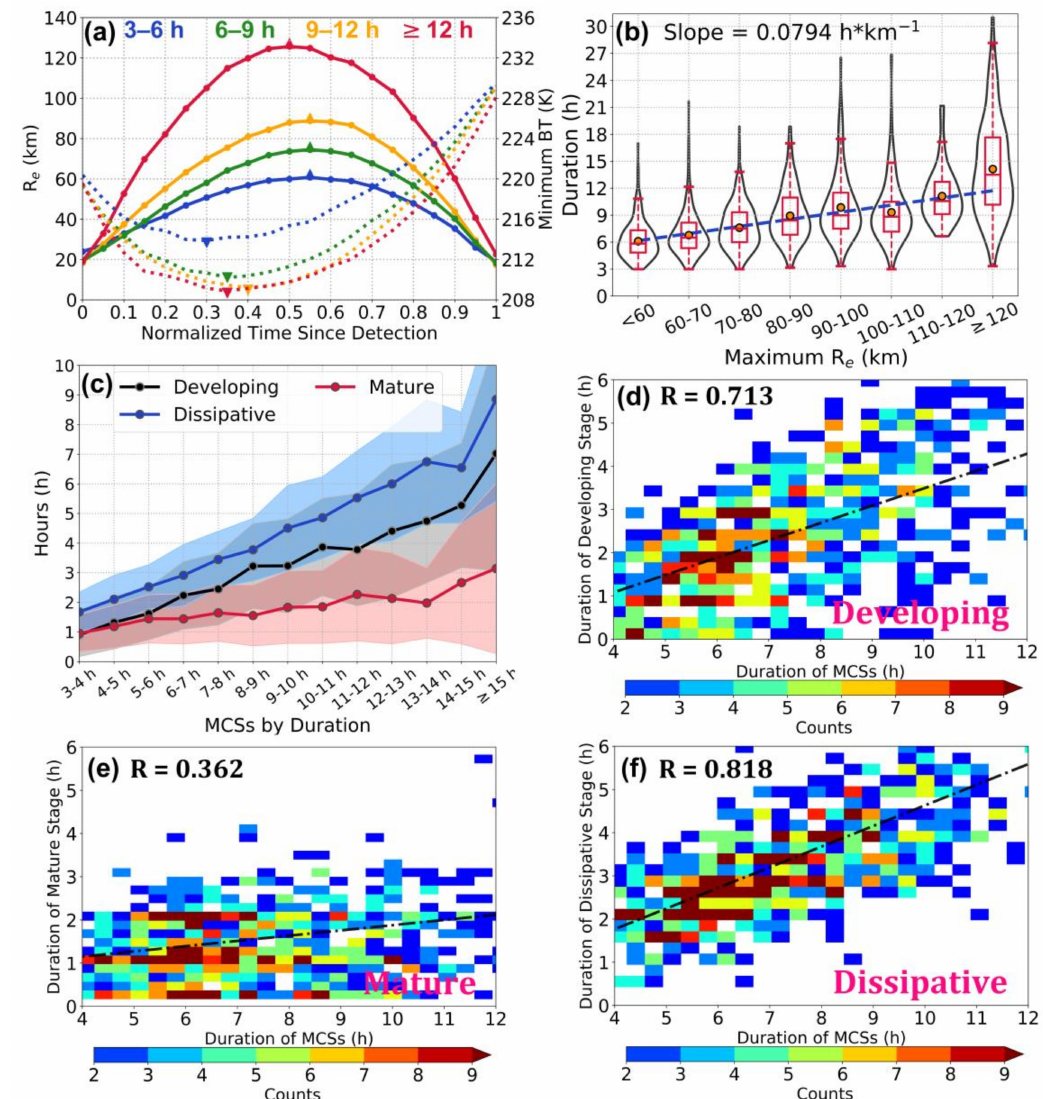
Figure 6. ( a ) Temporal evolution of the maximum R e (solid curves) and minimum BT (dashed curves) of MCSs with di ff erent lifetimes (in color), which is normalized between 0 and 1, and discretized into 20 equal steps. ( b ) Violin plots showing the durations of MCSs as a function of maximum R e , where the red dots denote medians of samples, and the blue dash line is the least square linear fitting line. ( c ) The duration of developing, mature, and dissipative stage, shown as a function of various MCS types with di ff erent lifetimes. The color shading represents standard deviation. ( d ) The histogram showing the two-dimensional distribution of samples as a function of duration of MCS and duration of the developing stage. The color shading represents the number of samples in each bin, and the black line denotes the regression line obtained by the least square method. The value of R denotes the correlation coe ffi cient. ( e ) Same as ( d ), but for the mature stage. ( f ) Same as ( d ), but for the dissipative stage. It should be noted that all the R values for the developing, mature, and dissipative stages are significant at 99% significance level, and only the MCSs of Type d are used here and in the following figures unless otherwise noted, given the nature having an entire life